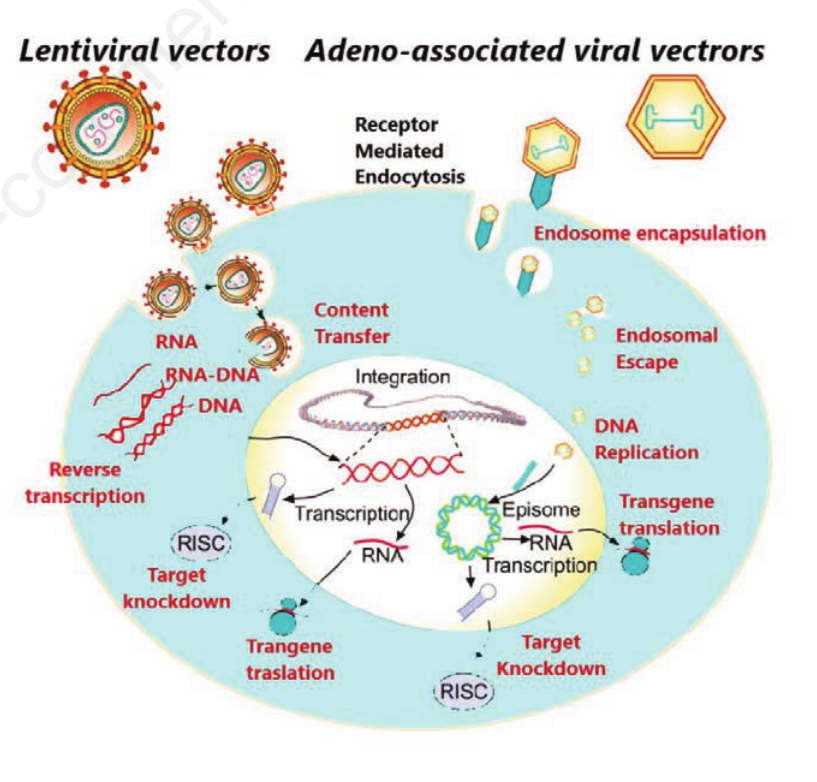
Figure 2. Lentiviral and adeno-associated viruses vector infection. Both vector systems are capable of transgene expression and endogenous gene